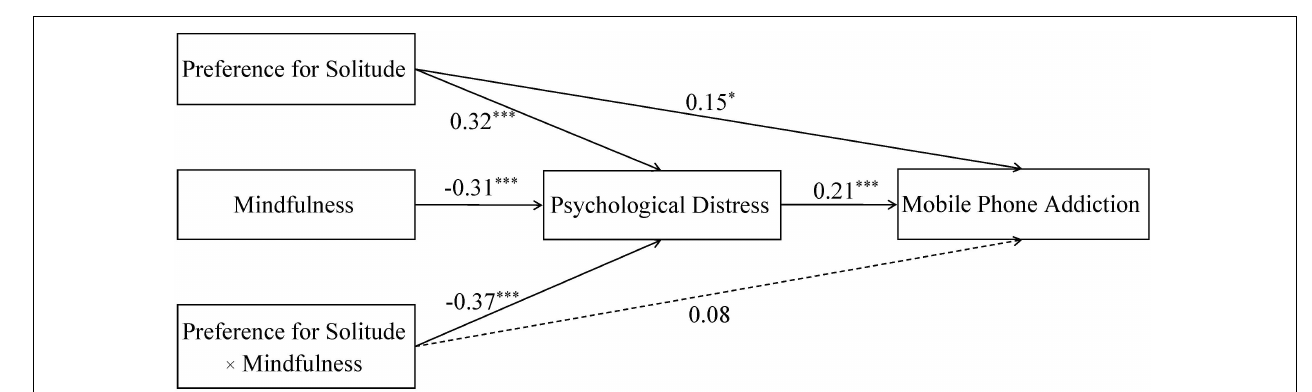
FIGURE 2 | Moderated mediation analysis ( N = 927). * p < 0.05, ** p < 0.01, and *** p <